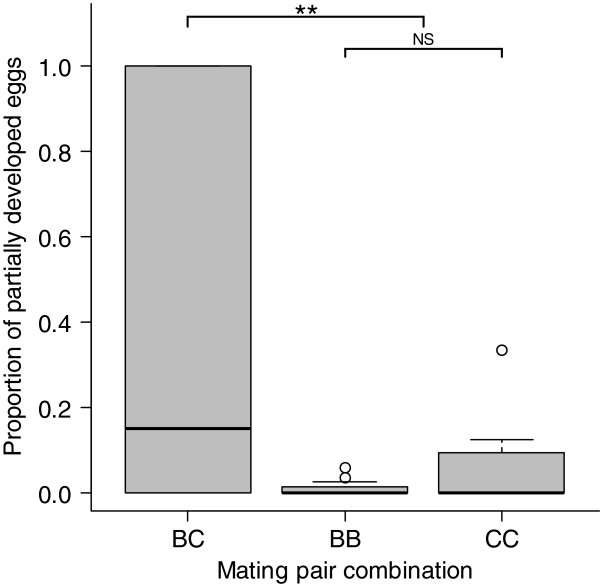
The proportion of eggs that only partially developed across the mating pair types. In each combination, female species is denoted by the first letter, and male species by the second. Data are displayed as medians (thickened line) and inter-quartile ranges (grey boxes), circles are outlying values. While BB and CC mating pairs do not differ in the proportion of eggs that only partially develop, heterospecific (BC) mating pairs differ from the conspecific (BB & CC) mating pairs. Statistical significance: NS P > 0.05; ** P < 0.01.